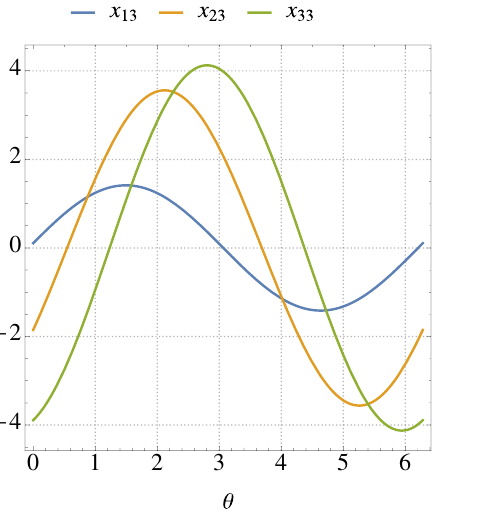
= 25 TeV, m = 20 f (cid:30) 2